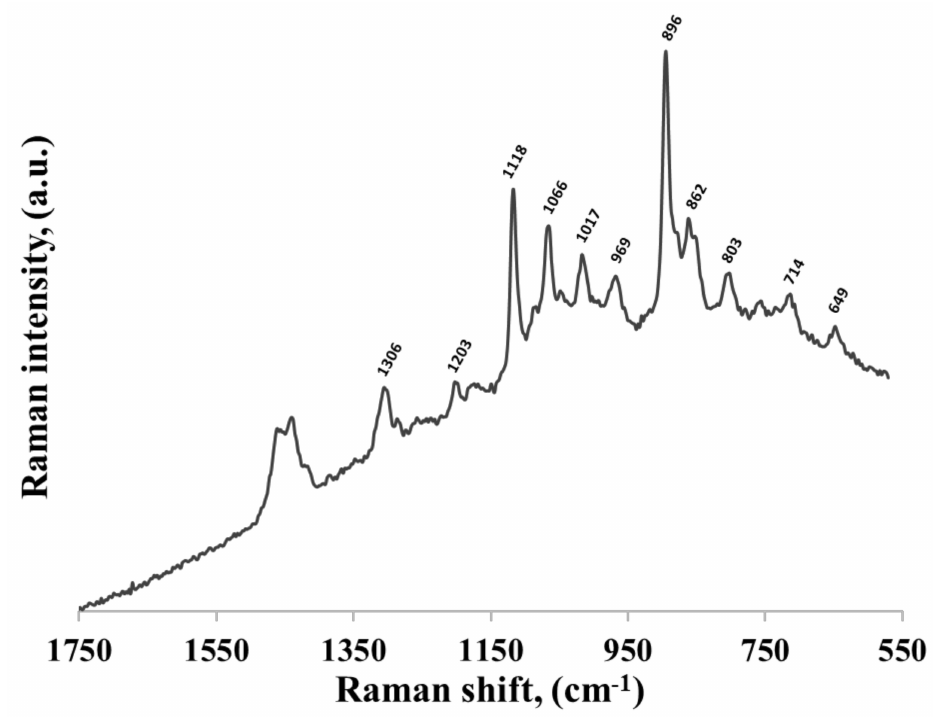
Figure 3. SERS spectrum of 1-hexanethiol adsorbed on the surface of gold